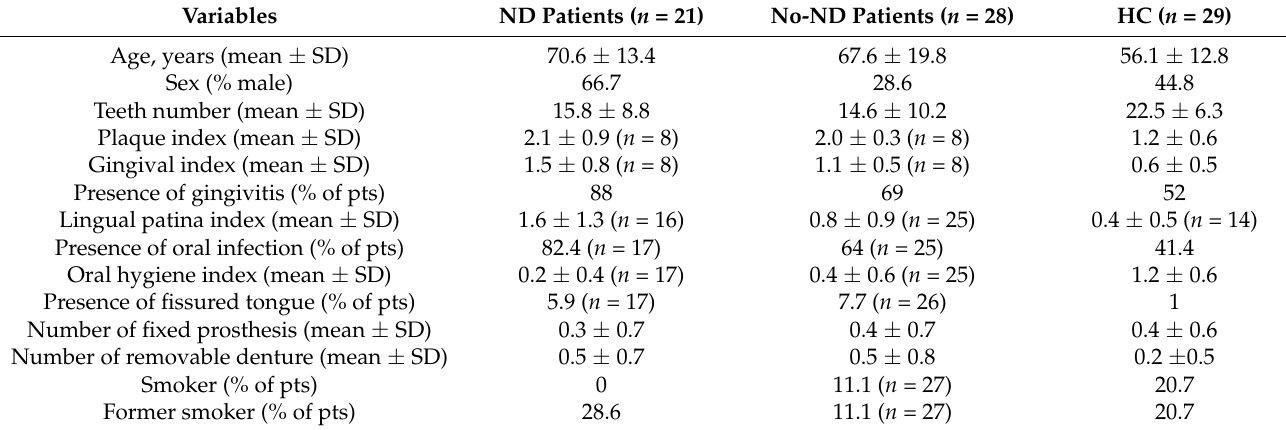
Table 1. Demographic characteristics and oral indices of all participants of the groups included in the study. Otherwise, the number of patients included in the calculation is shown in